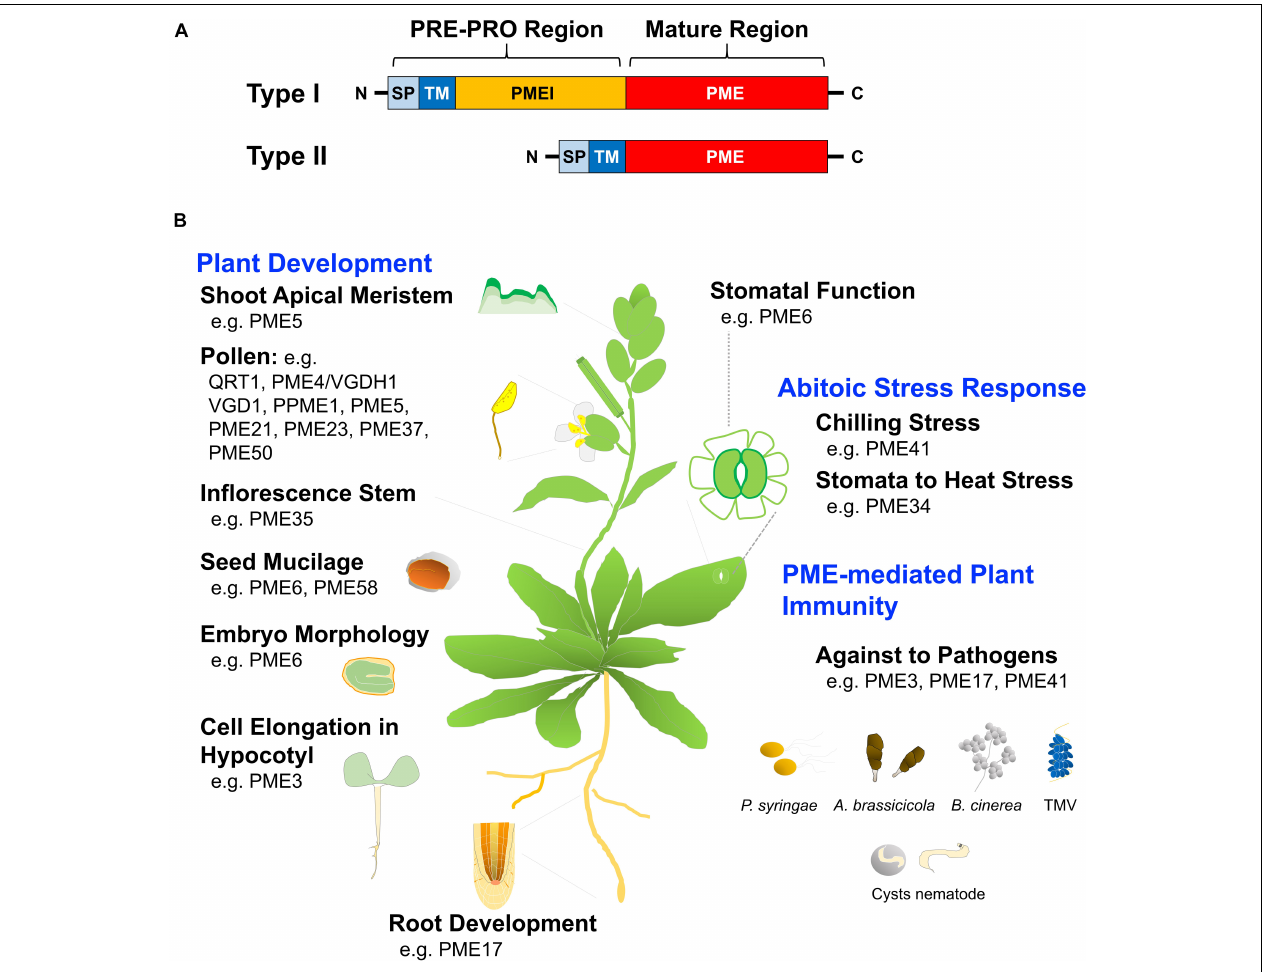
FIGURE 4 | Structural motif and function of pectin methylesterase (PME). (A) Types I and II PMEs contain a conserved PME domain, as the active part of the proteins. Type I includes the N-terminal extension of the PRE-PRO region, with the PRE domain containing a signal peptide (SP) or a transmembrane domain (TM) that is required for PME targeting to the cell wall. The N-terminal PRO region shows homology with pectin methylesterase inhibitors (PMEI), whereas type II is characterized by the absence of the PRO region. (B) Deficiency in specific PME genes reveals multiple roles of PME that have been linked to alteration of plant growth development and the response of plant defenses and abiotic stresses, respectively; related references are indicated in Table 1